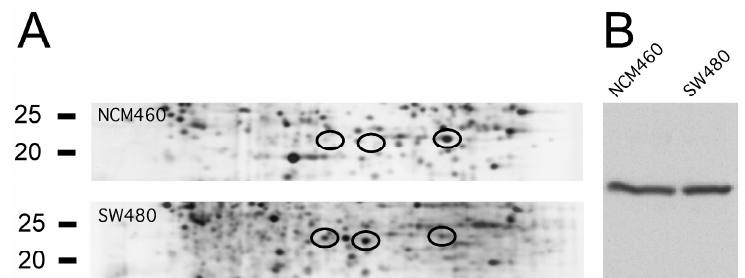
Figure 6. Expression of triosephosphate isomerase. ( A ) In 2-dimensional polyacrylamide gel electrophoresis (2D-PAGE), the protein migrates as at least 3 proteoforms (indicated with black circles) with varying isoelectric points but similar molecular masses that each vary in